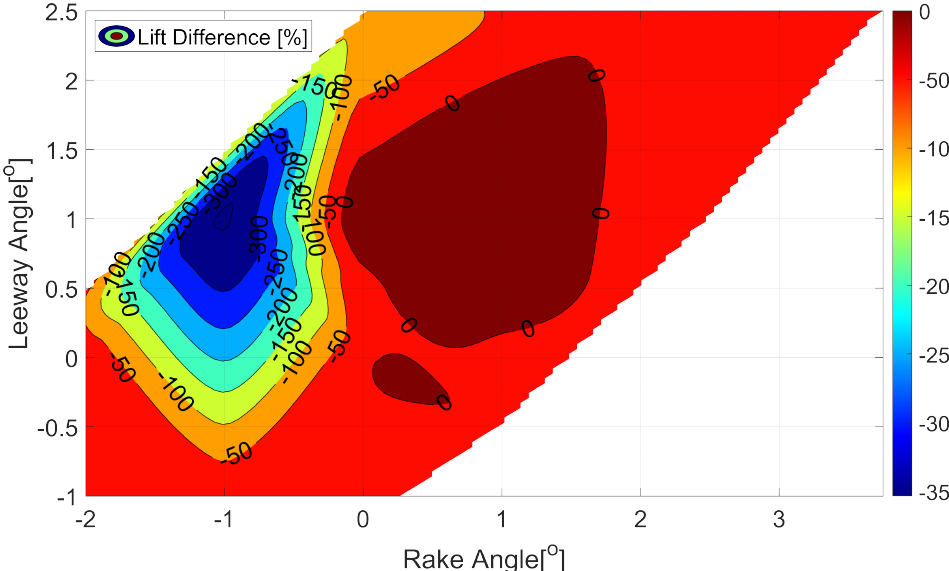
Figure 33. Difference between the computed and the measured lift force at 9 m/s, dimensions are in